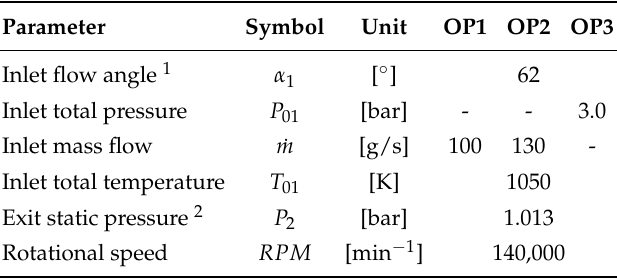
Table 1. Definition of boundary conditions for the optimization.